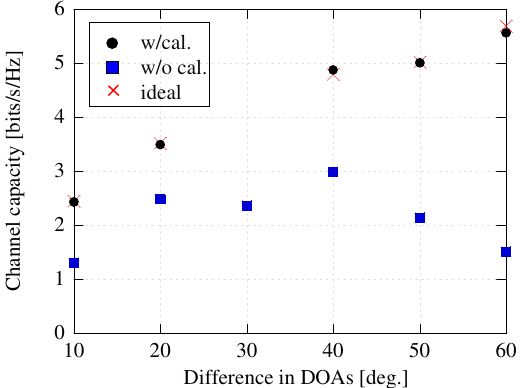
Figure 11. C vs. difference in directions of arrival (DoA) between desired and interference signals ( θ d = 0 ◦